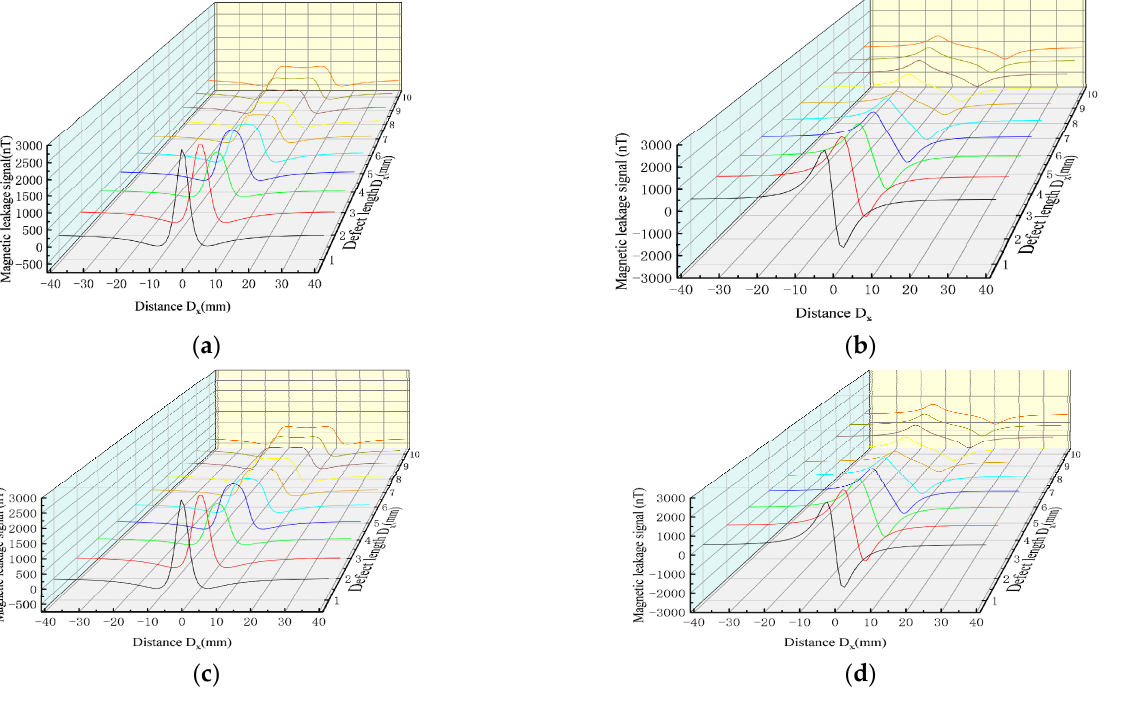
Figure 12. Comparative analysis of MFL signals between improved magnetic charge model and classical magnetic charge model under different defect lengths. ( a ) MFL of the axial component of improved magnetic charge model with different defect lengths. ( b )MFL of the radial component of improved magnetic charge model with different defect lengths. ( c ) MFL of axial components of classical magnetic charge model with different defect lengths. ( d ) MFL of radial components of classical magnetic charge model with different defect lengths.